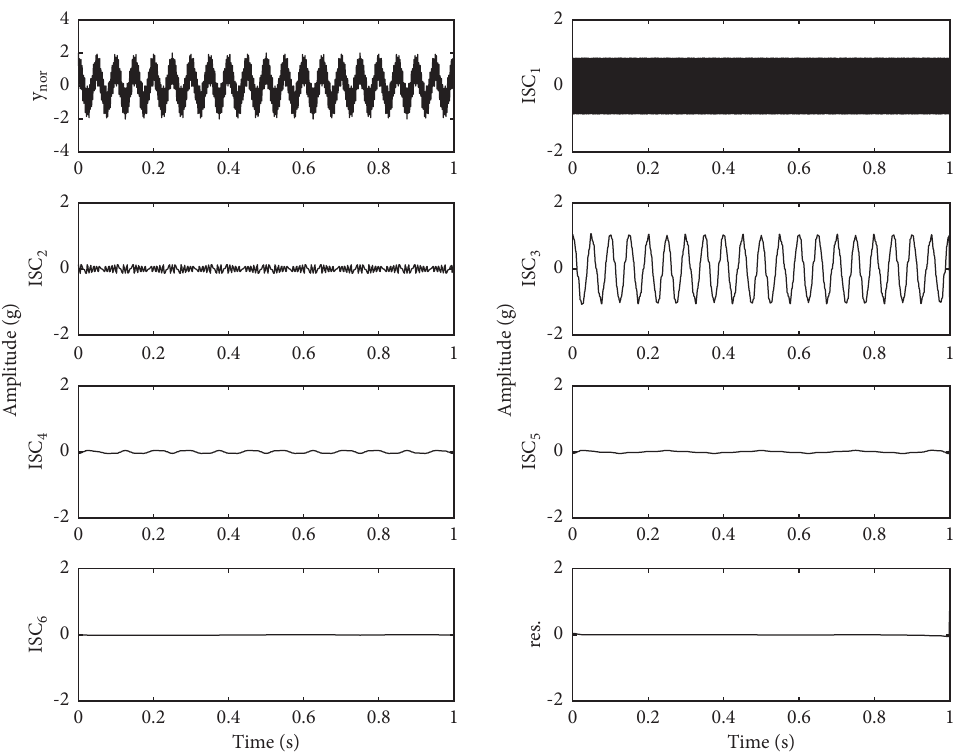
Figure 4: LCD decomposition results of y-channel under normal conditions.